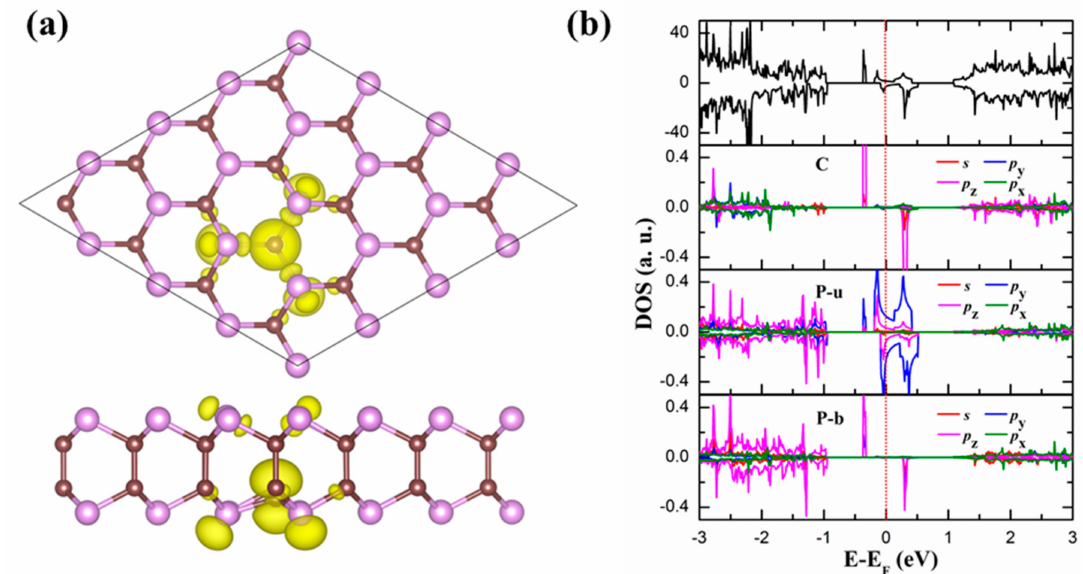
Figure 4. ( a ) Top and side views of the magnetization charge density, and ( b ) total DOS and PDOS of the 2D PC with one C vacancy. In panel ( a ), the isosurface value is 0.003 e / a 3 level is set to zero, and C, P-u, and P-b present the nearest C atom, the nearest P atom in the upper sublayer, and the next-nearest P atom in the bottom sublayer.